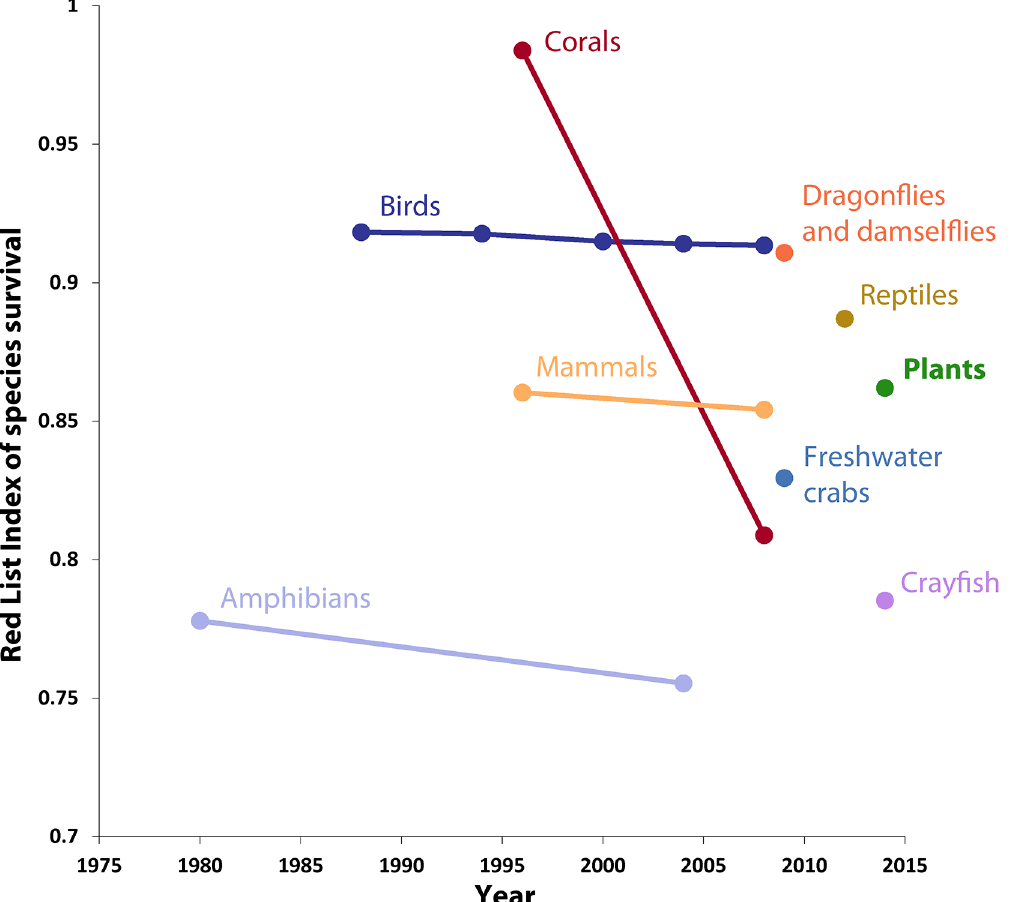
Fig 3. Red List Indices for birds, mammals, amphibians and corals (source: IUCN), with baseline values for crayfish [13], freshwater crabs [16], dragonflies & damselflies [17], reptiles [19] and plants (this study). Values for crayfish, freshwater crabs, dragonflies and damselflies, reptiles and plants are based on a sampled